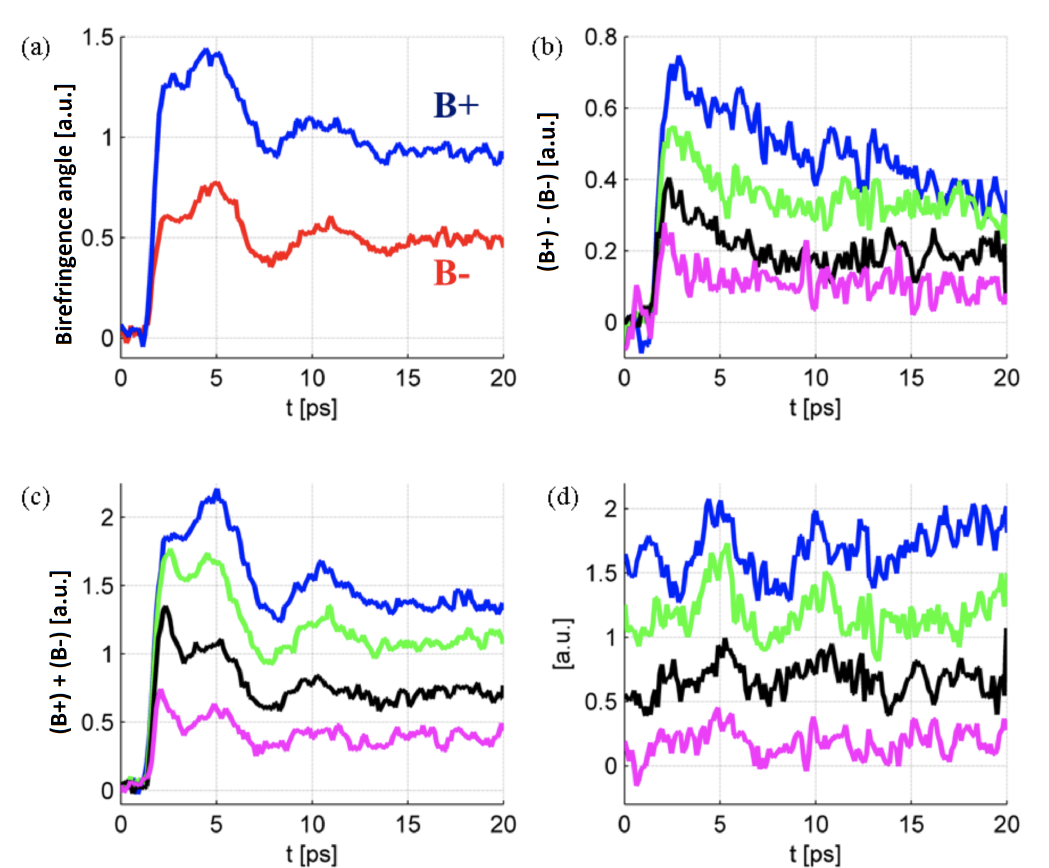
Figure 2. ( a ) The THz-induced birefringence in Ni using an external mechanical chopper under and external magnetic bias B+ & B− with a fluence of 190 mJ/cm 2 . ( b ) The extracted magnetic response (demagnetization) obtained from B+ −B−. Blue, green, black, and magenta refer to the fluences of 47, 85, 123, & 190 mJ/cm 2 . ( c ) the total electronic and structural response is obtained using (B+) + (B−) which contains both thermal excitation and acoustic phonons. The latter is independently shown in ( d